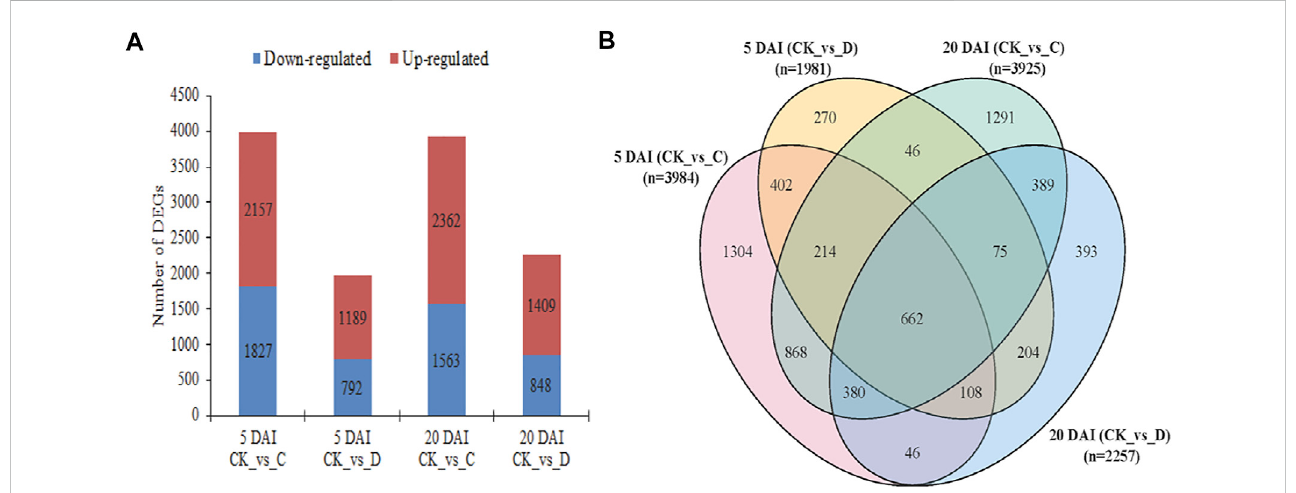
FIGURE 3 Differentially expressed genes (DEGs) in coconut leaves were detected in C (15 males and 21 females) and D (20 males and 28 females) RPW population densitiesascomparedtothecontrol(CK)on5and20DAI. (A) BargraphofdetectedDEGs(bothdown-andupregulated). (B) VenndiagramofDEGsdetected in the four treatment comparisons. n = number of DEGs detected in each pairwise